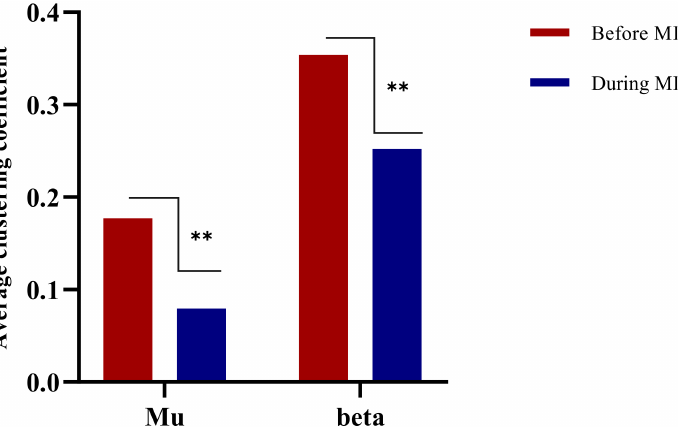
Figure 8. Histogram of average clustering coefficient change. ** means that there is a significant difference between two different